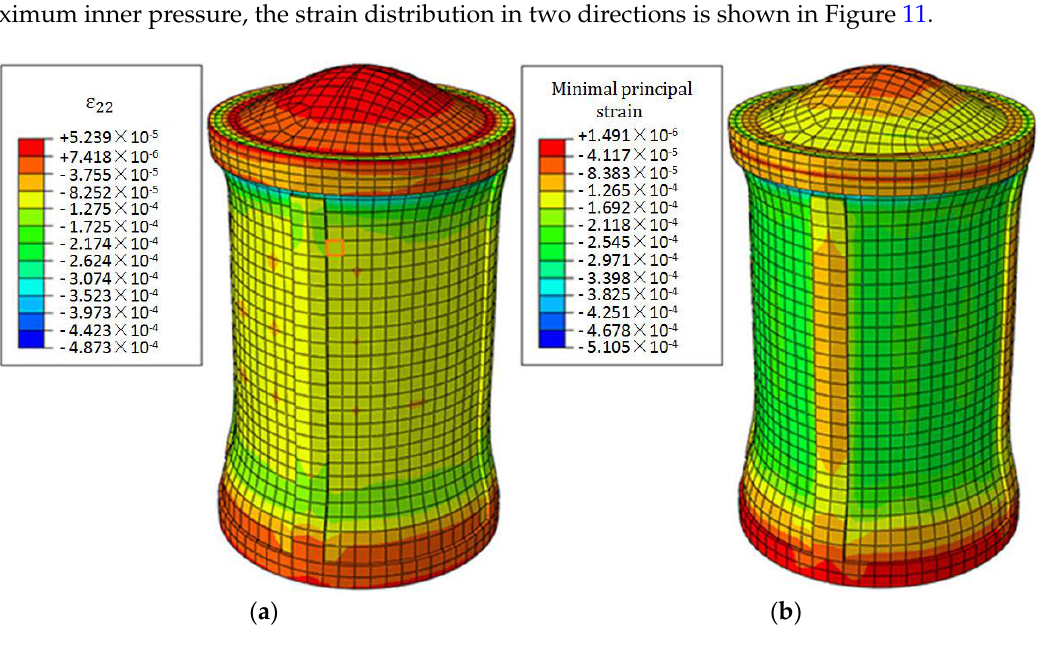
Figure 11. The strain distribution contour in two directions at the maximum inner pressure. (Deformation scale factor is 500.) ( a ) Vertical direction strain contour; ( b ) Circumferential direction strain contour.